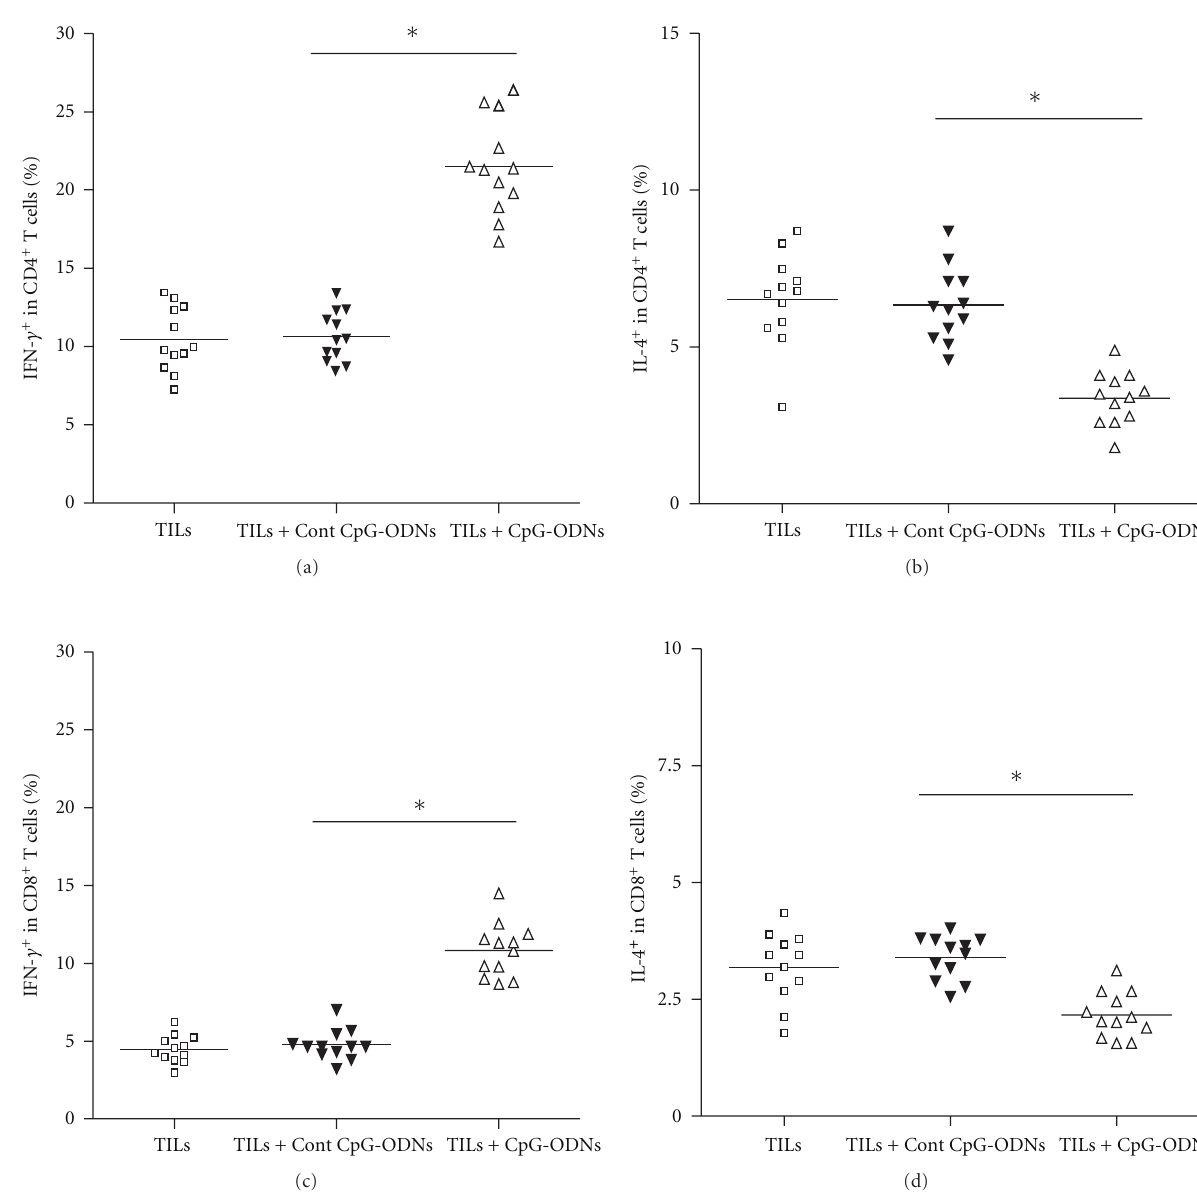
Figure 4: CpG-ODNs enhanced the IFN- γ production of CD4 + T cells and CD8 + T cells. TILs were collected from lung cancer patients ( n = 12) and treated with CpG-ODNs or control CpG-ODNs as described in Materials and Methods. 1 × 10 7 autologous TILs were transferred into the tumor bearing Balb/c nude mice with 100 ug CpG-ODNs or control CpG-ODNs through tail vein. Ten days later, CD4 + T cells and CD8 + T cells were isolated from tumor mass and their production of IFN- γ (a and c) and IL-4 (b and d) was detected by intracellular staining. ∗ P < .